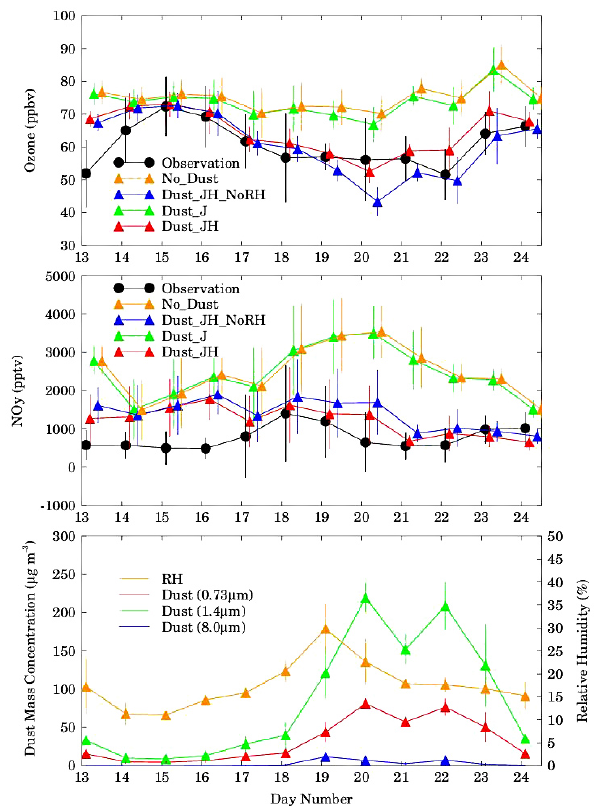
Figure 2. Variations in observed and WRF-Chem-simulated (No_Dust, Dust_JH_NoRH, Dust_J and Dust_JH) daily average O 3 (top panel) and NO y (middle panel) at Nainital during 13–24 April 2010. WRF-Chem-simulated daily average mass concentration of dust particles of 0.73, 1.4 and 8.0µm effective radii and relative hu- midity at Nainital are also shown. The vertical bars represent stan- dard deviation in the average